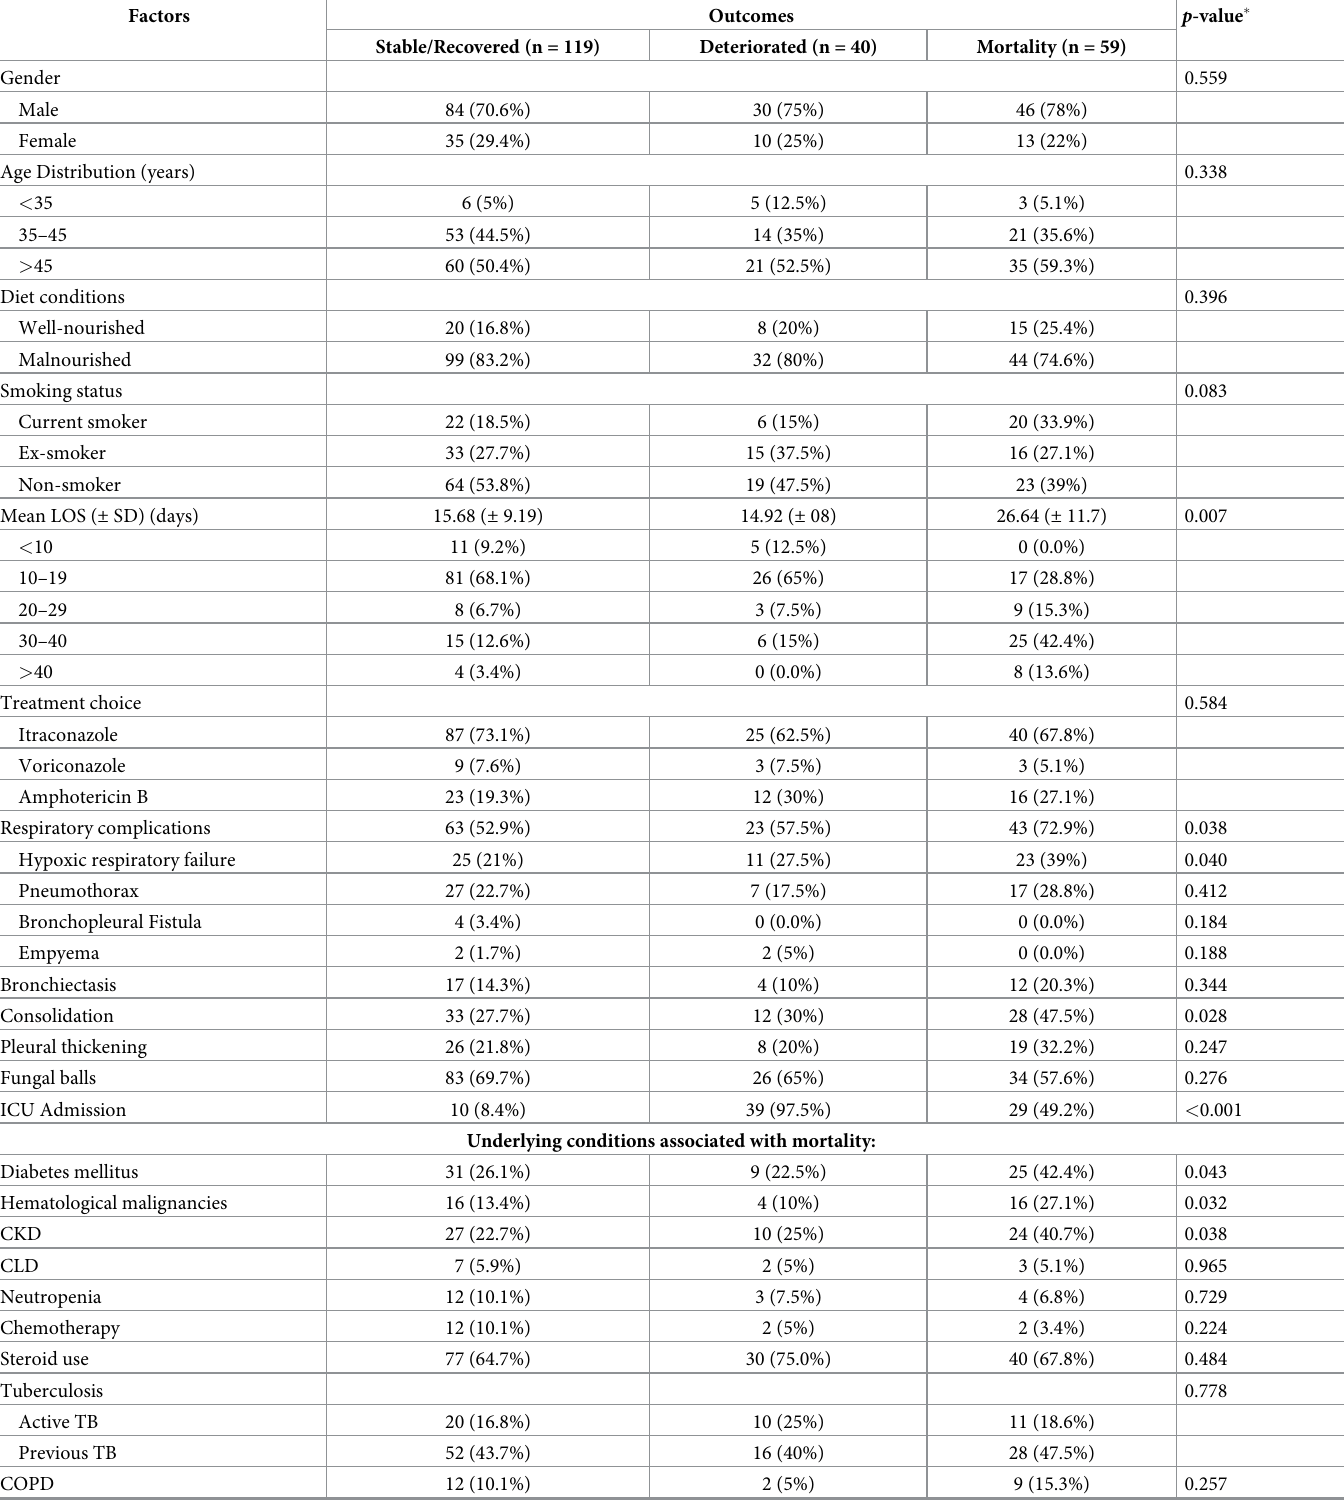
Table 5. Factors associated with outcomes and independent risk factors associated with